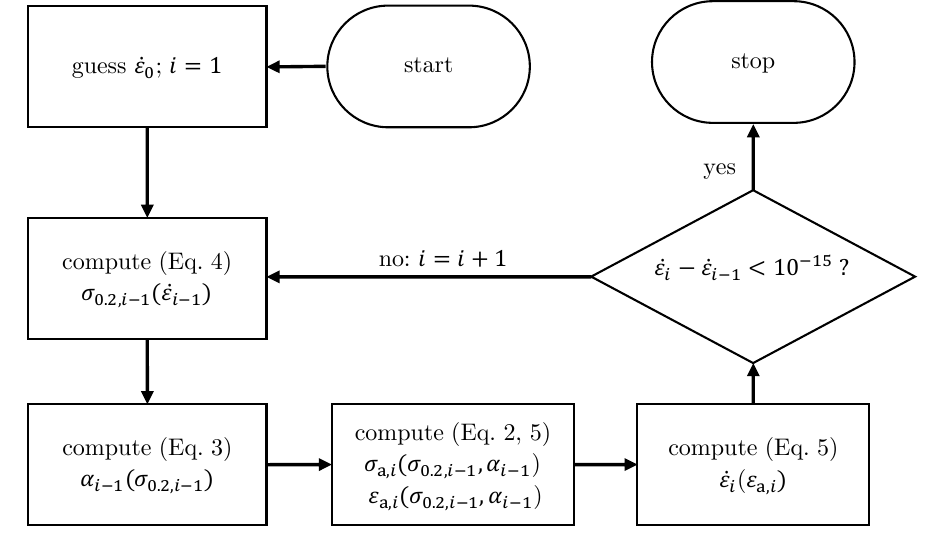
Figure 7. Algorithm used in this study to compute corrected load